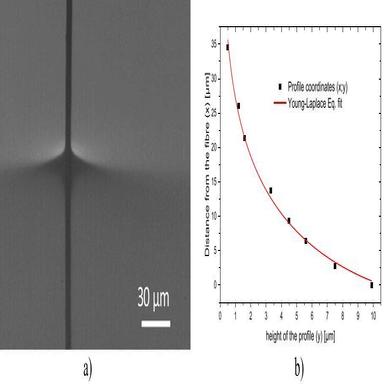
wetting profile of the pristine single CF strand immersed in hexadecane (a); plotted profile as measured on the picture (dots) and the corresponding Young-Laplace fitting (line) (b). For easier fitting purpose, coordinates axes are shifted to the right. (For interpretation of the references to colour in this figure legend, the reader is referred to the web version of this article.)